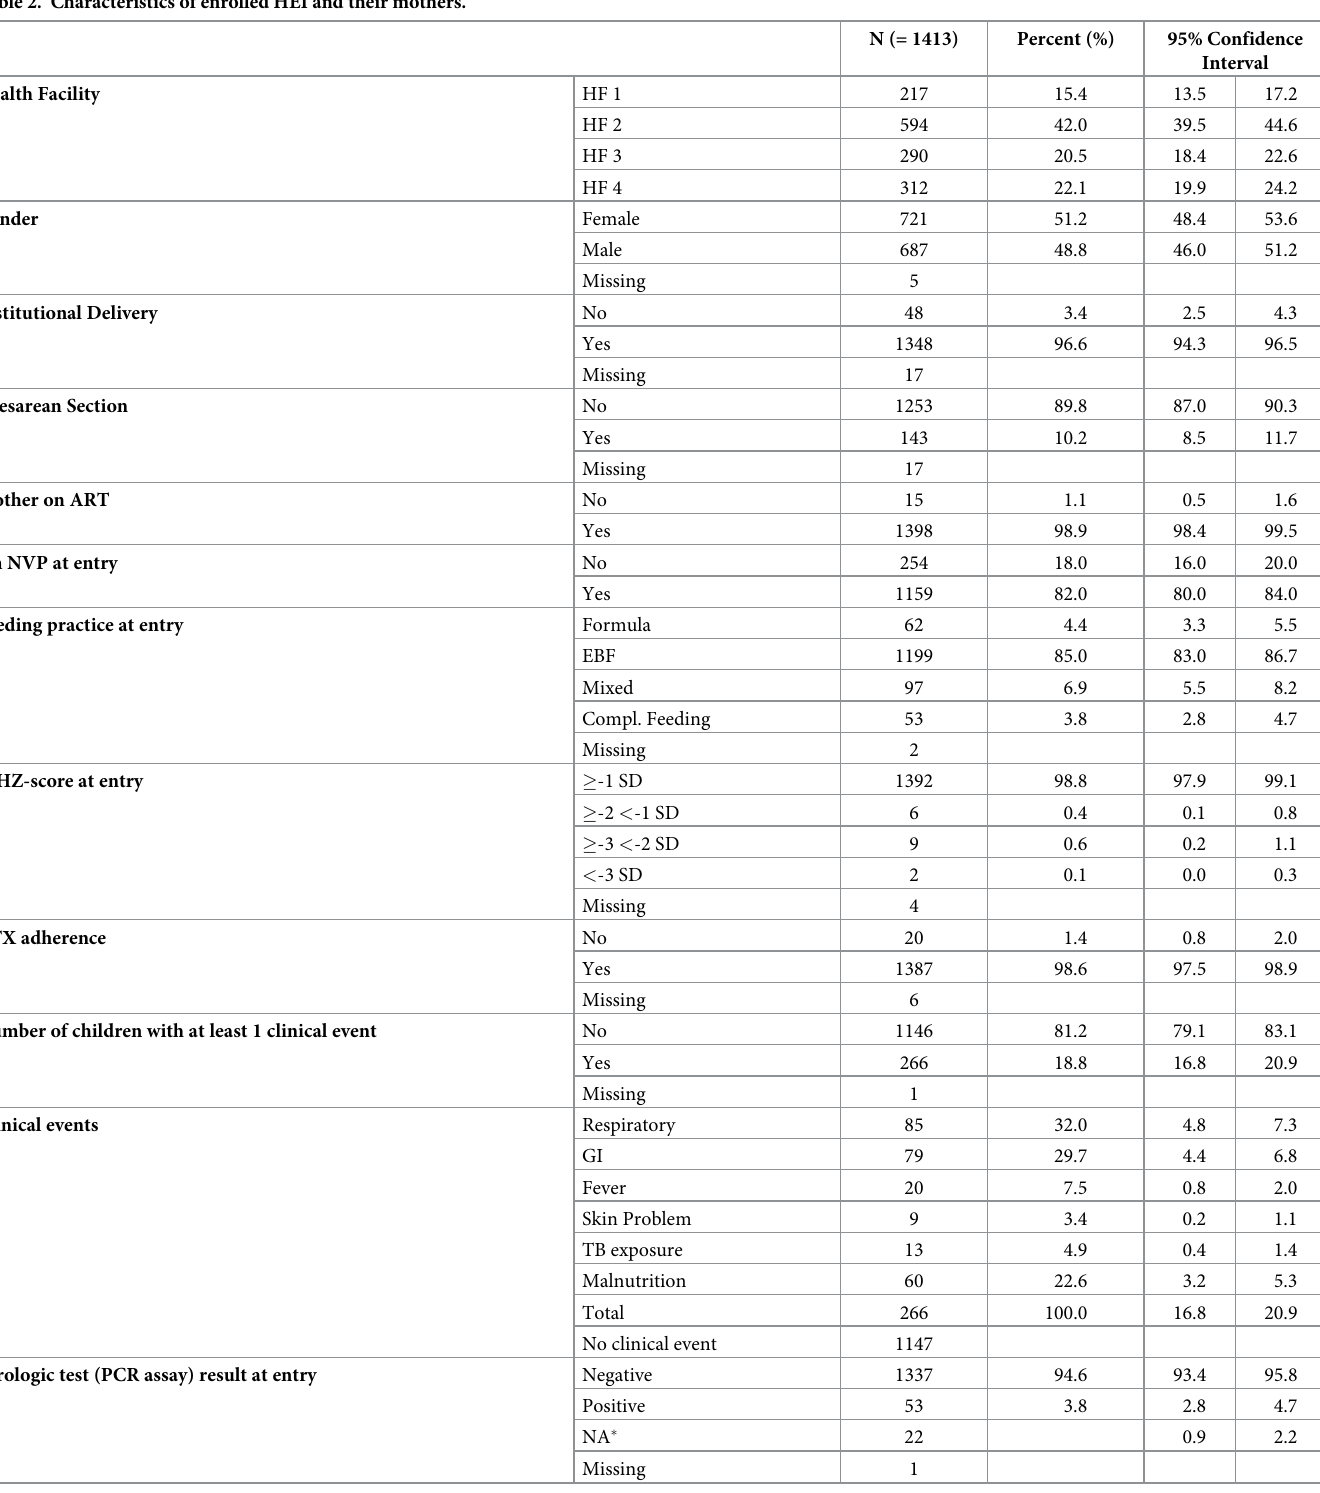
Table 2. Characteristics of enrolled HEI and their